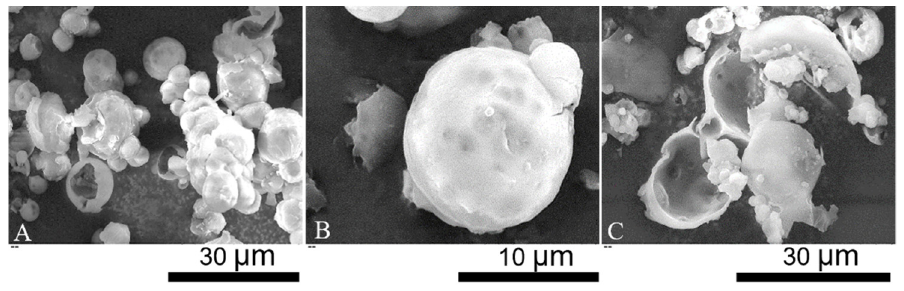
Figure 2. SEM micrographs: overview of single/clusters of microcapsules ( A ); spherical microcapsule with subshell oil ( B ); incomplete microcapsules and polymeric debris ( C ).